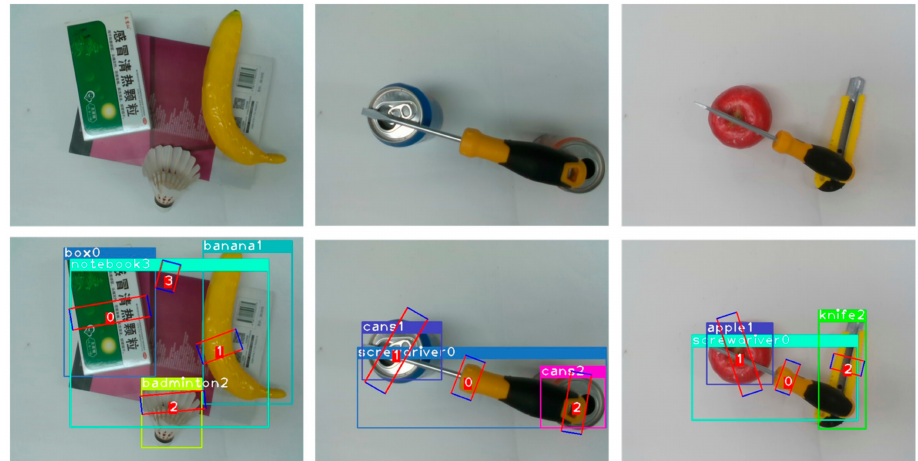
Figure 8. Second test set sample. The three images above are the original images from the its and the following are the results of the test.